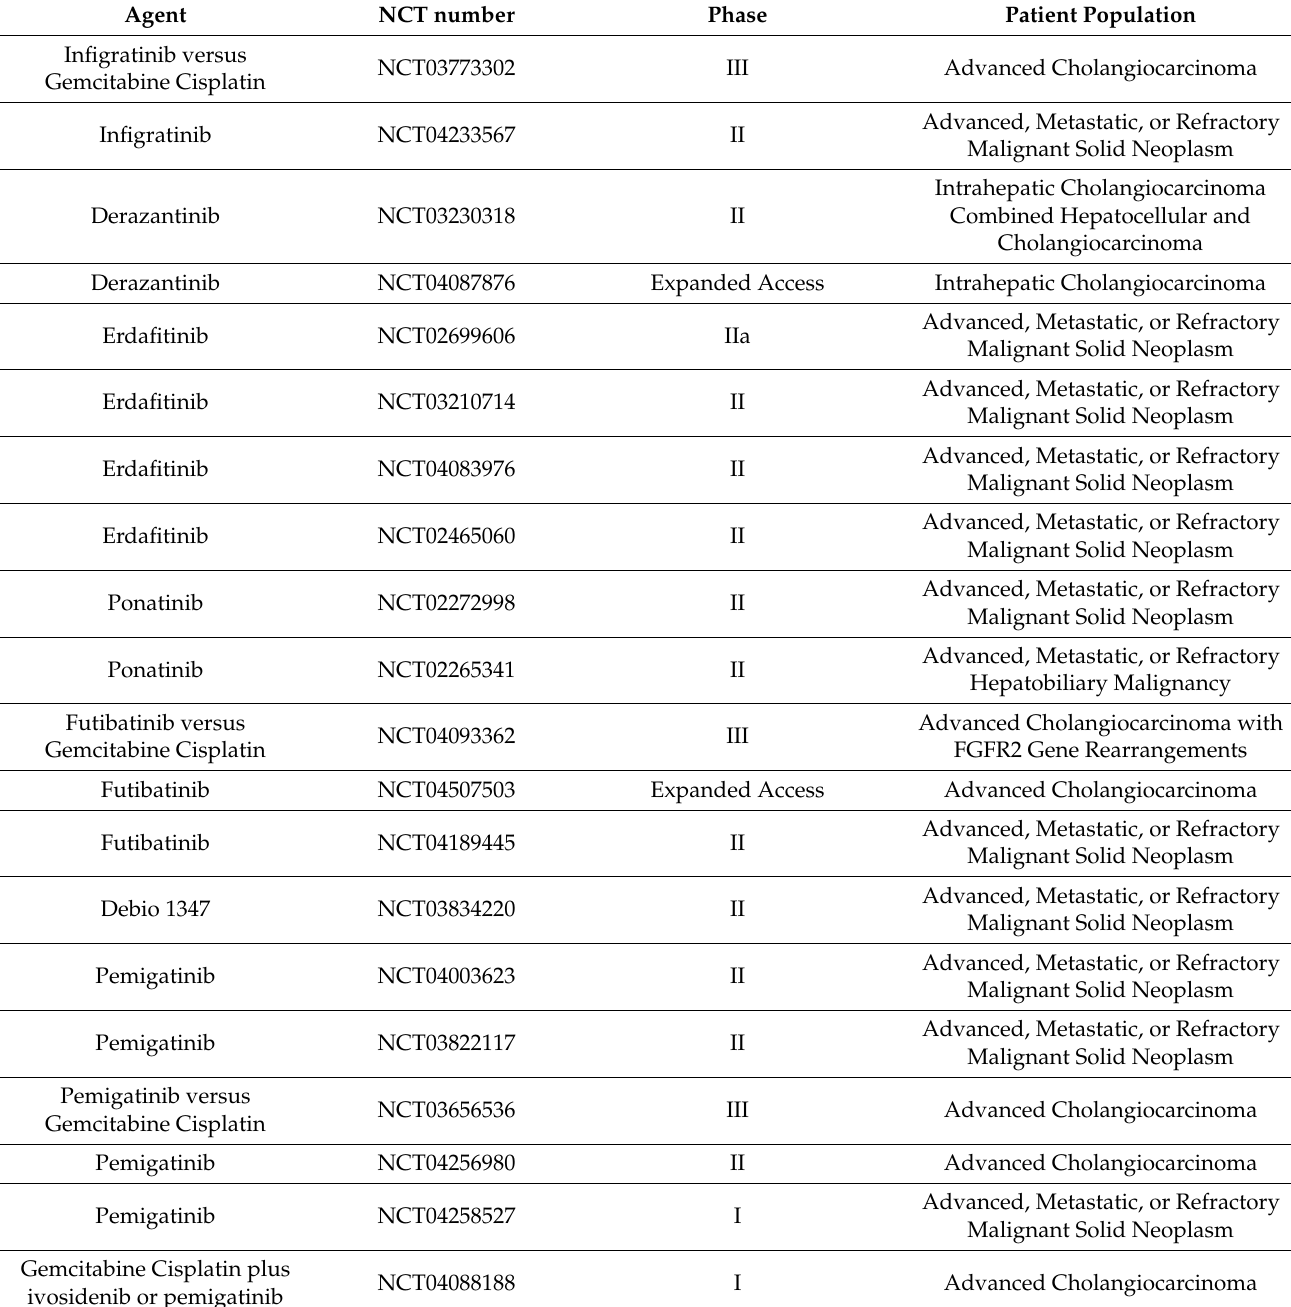
Table 2. Ongoing clinical trials on FGFR inhibitors in advanced cholangiocarcinoma.